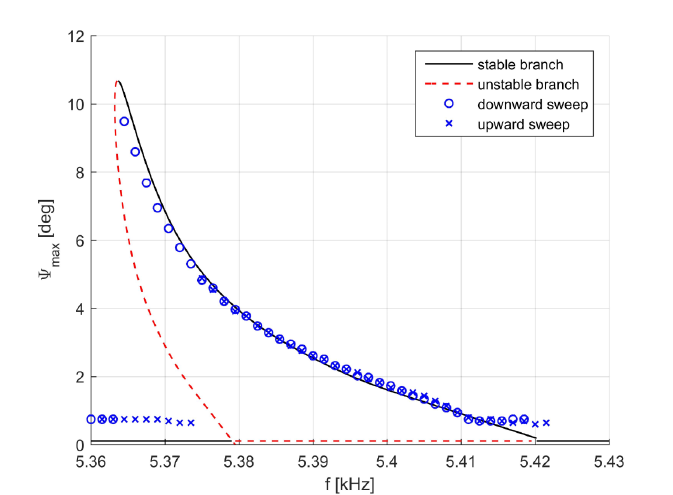
Figure 2. Sinusoidal excitation in the range of 5 kHz, V 0 = 55 V; experimental upward and downward sweep (discrete symbols) and numerical continuation (continuous and dashed